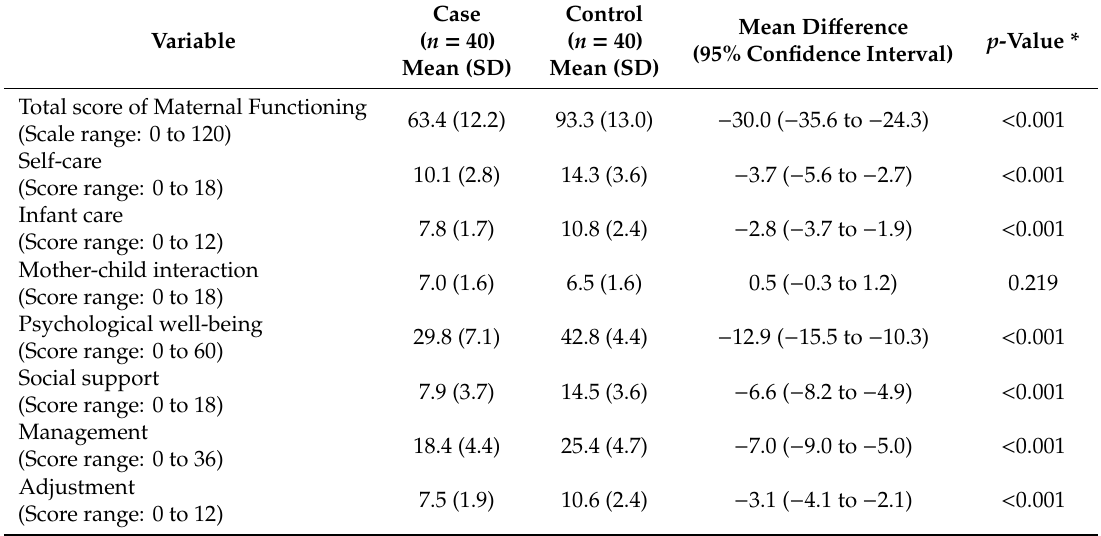
Table 2. Comparison of maternal functioning and its dimensions in the case and control